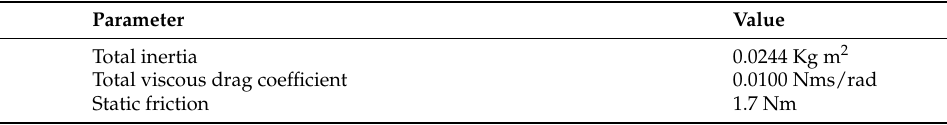
Table 4. Mechanical parameters of drill